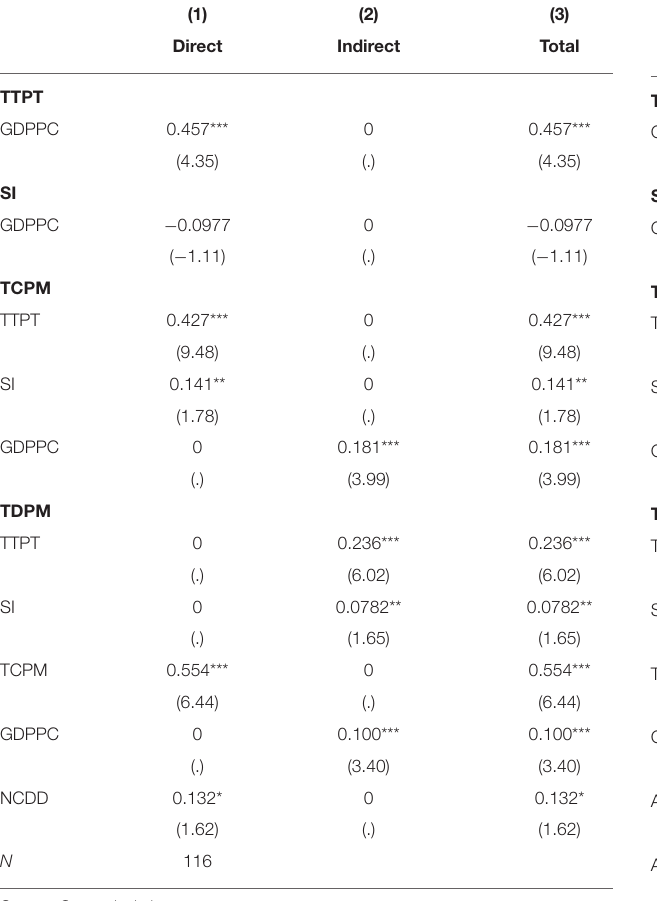
TABLE 10 | Direct, indirect, and total effects of the determinants of COVID-19 deaths via NCDD with regional